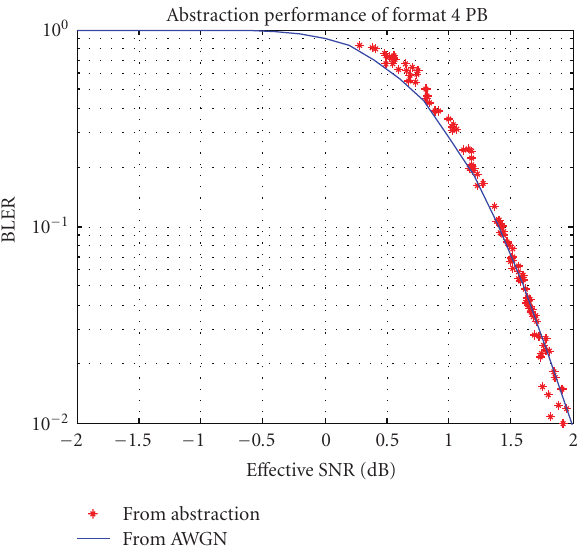
Figure 7: Abstraction of beta ( β ) in Ped B channel.